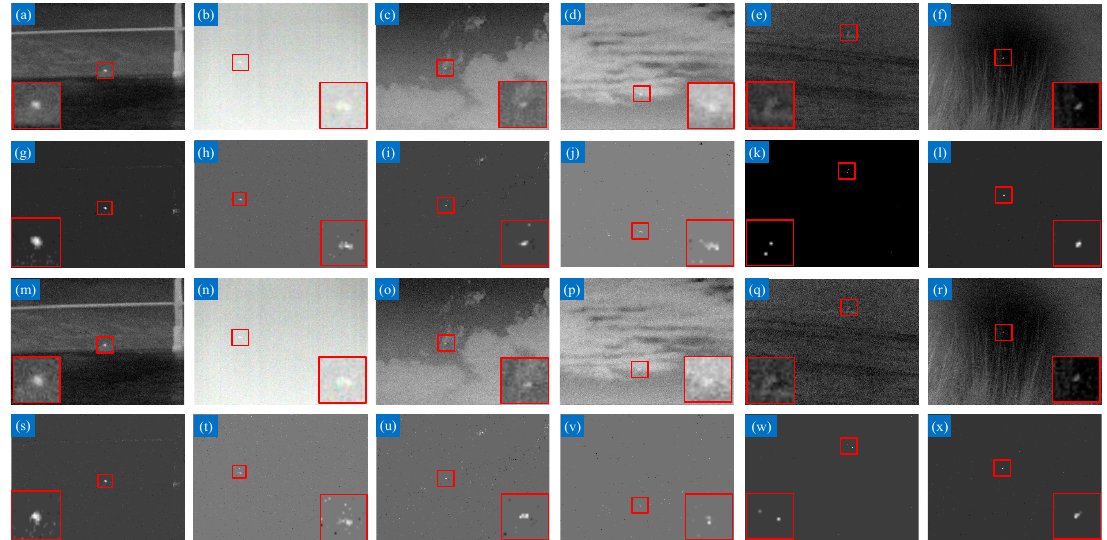
Figure A9. The first and third row show infrared images with additive white Gaussian noise with standard deviation of 10 and 20, and the second and fourth rows are the corresponding detection results by IPI.